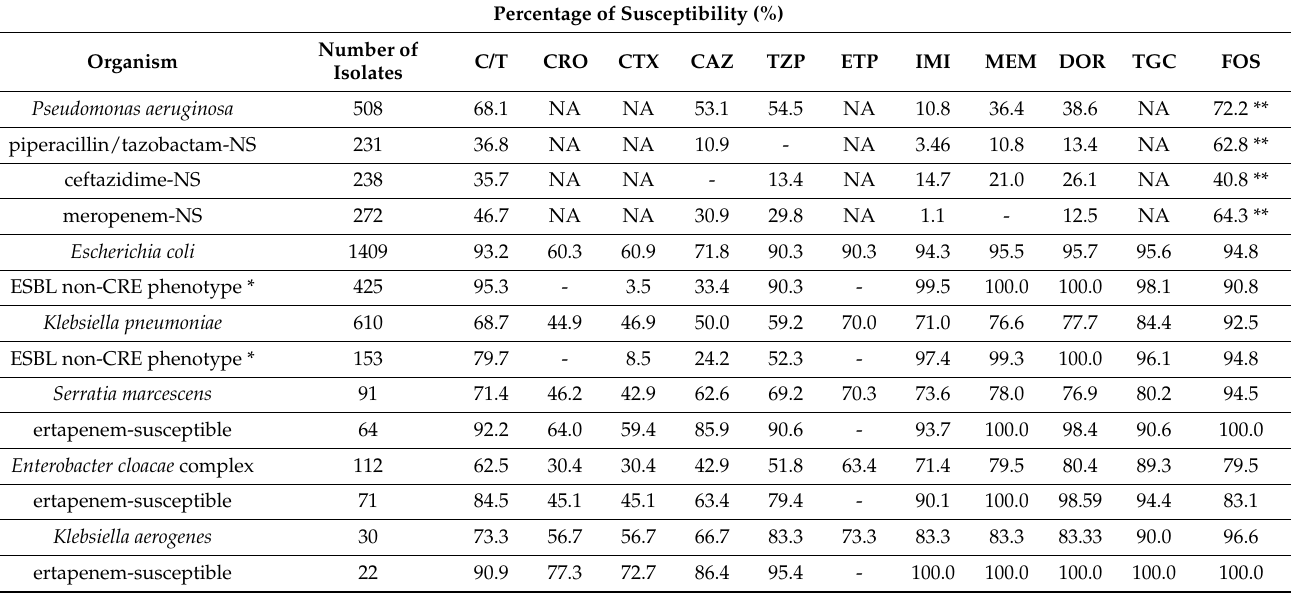
Table 1. Susceptibility of phenotypic subsets of clinical isolates of P. aeruginosa and Enterobacterales to C/T and comparator agents between 2016 and 2017 from five Latin American